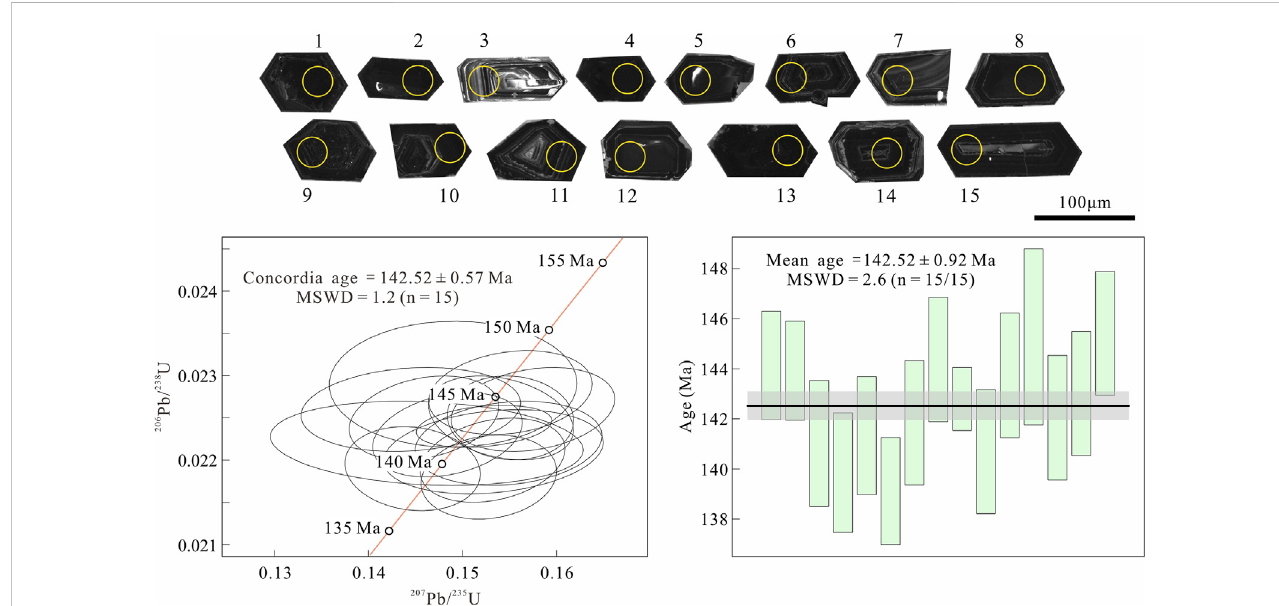
FIGURE 5 Cathodoluminescence images, U – Pb concordant age, and weighted mean age of zircons from BHSG.